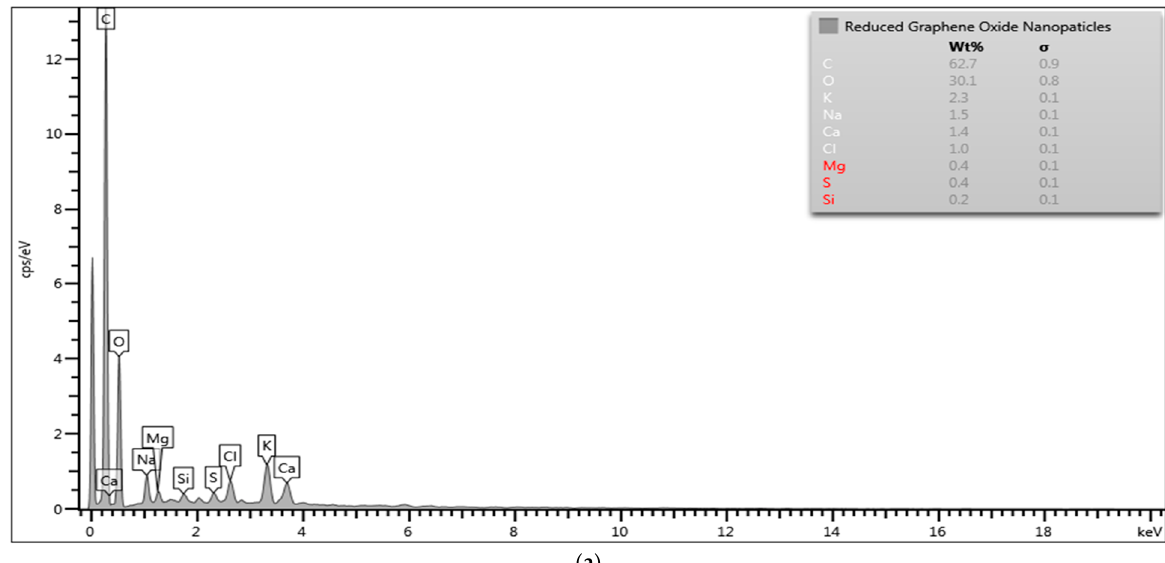
Figure 9. ( a ) TEM image for lattice space analysis. ( b ) TEM image of reduced graphene oxide nanomaterials. ( c ) Selected Area Electron Diffraction (SAED) pattern.